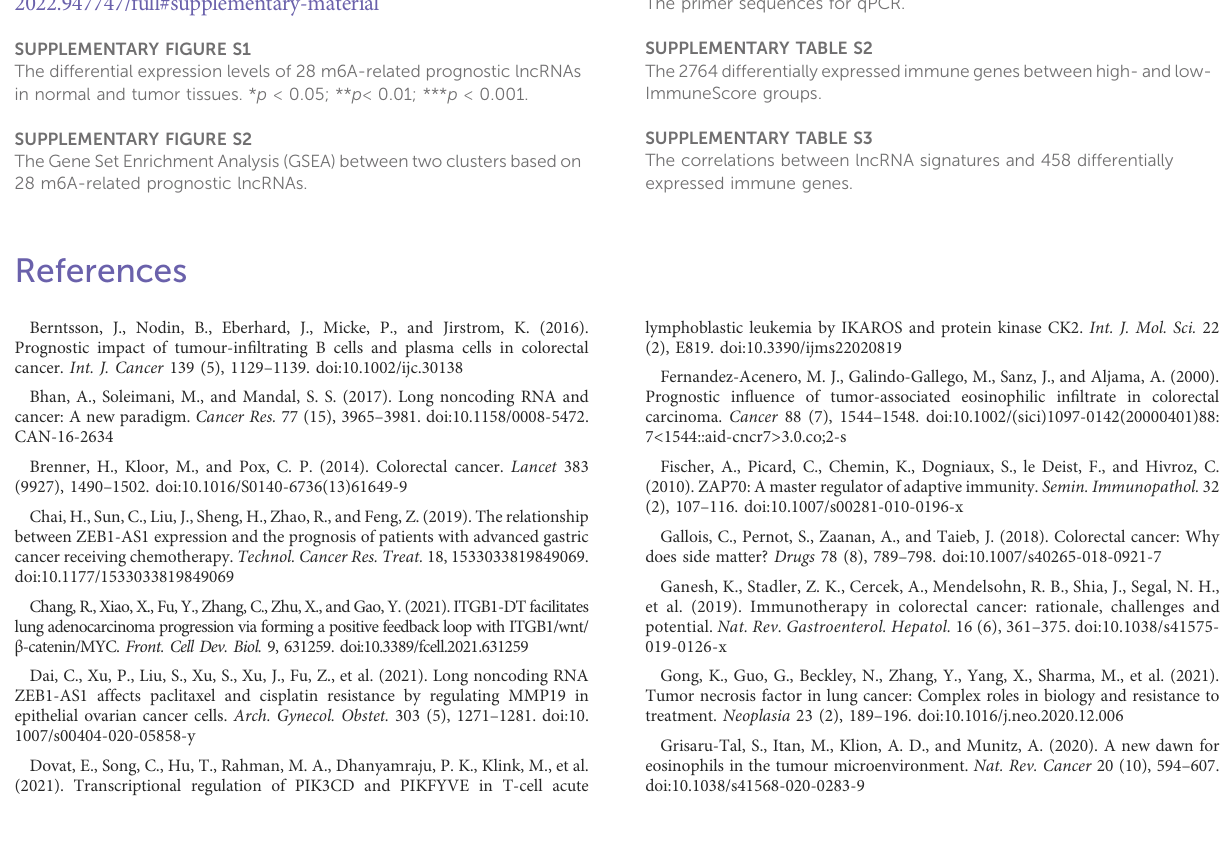
SUPPLEMENTARY FIGURE S3 ROC curves of the clinical characteristics and risk score. (B – D ) The Kaplan-Meier survival curves of the relative DFI, PFI, and DSS between the high- and low-risk group. (E) Correlations between the abundance of immune cells and 8 m6A-related lncRNA signatures in the proposed model. (F) Expression of immune checkpoints in the high and low-risk groups. * p < 0.05; ** p < 0.01; *** p < 0.001. SUPPLEMENTARY FIGURE S4 The Kaplan-Meier survival curves of OS differences strati fi ed by age, gender, pathologic stage, and TMN stages between the high- and low- risk group. SUPPLEMENTARY FIGURE S5 Relationships between lncRNA signatures and drug-sensitivity (IC50 value). SUPPLEMENTARY FIGURE S6 Box plots of individual immune genes expression in CRC based on GEPIA analysis. (B) Themultivariatecoxforestplotoftheimmunegenesrelated two lncRNA signatures in CRC by R package “ survival ” and “ forestplot. ” (C) Veri fi cation of the expression level of ZEB1-AS1 in GEPIA database. (D,I) Correlation between ZEB1-AS1 expression and tumor stage of CRC in GEPIA and TISCH database. (E – H) The prognostic value of mRNA levelofZEB1-AS1inCRC(Kaplan – Meierplotter)basedonthemedianand quartile distribution of ZEB1-AS1 expression levels. (J) Correlation heatmap of different expressed ZEB1-AS1 with EMT marker genes. * p < 0.05. SUPPLEMENTARY FIGURE S7 (A – S) The relationships between the expression of ZEB1-AS1 and important cancer signaling pathways in CRC. (T) The correlation between the expression of ZEB1-AS1 and the drug sensitivity of 5-Fu. SUPPLEMENTARY TABLE S1 The primer sequences for qPCR.